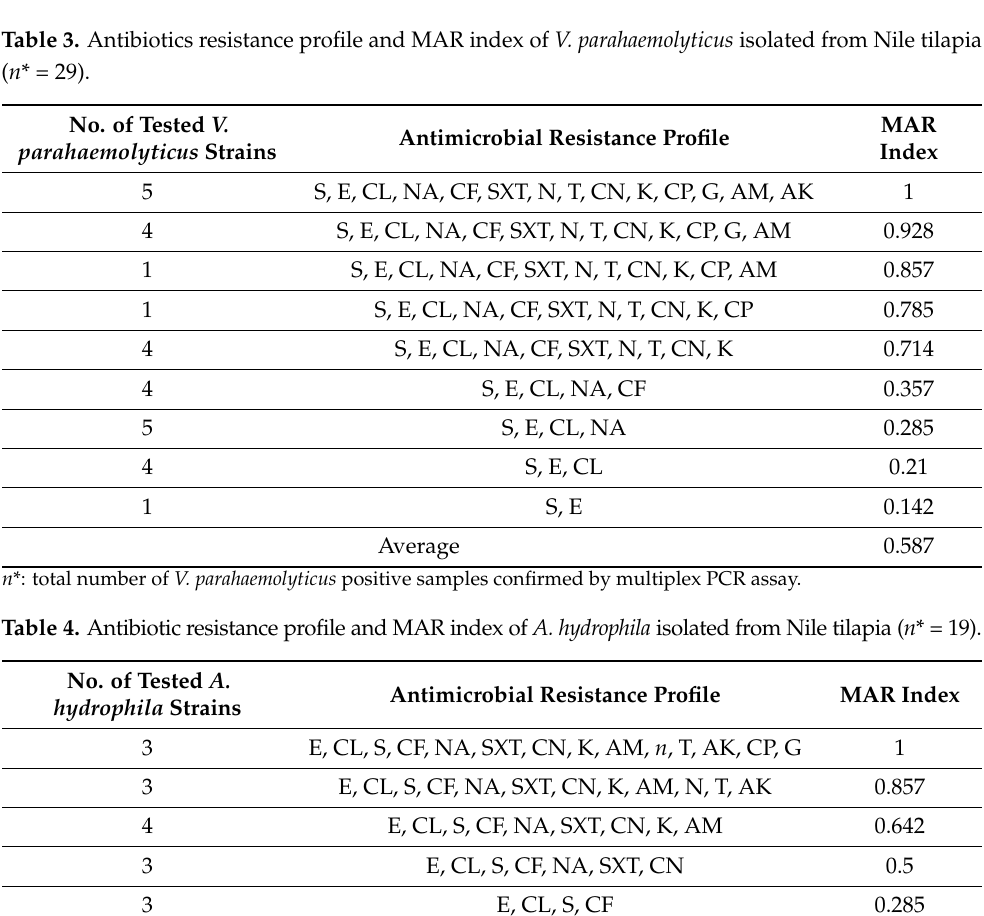
Antimicrobial Resistance Profile